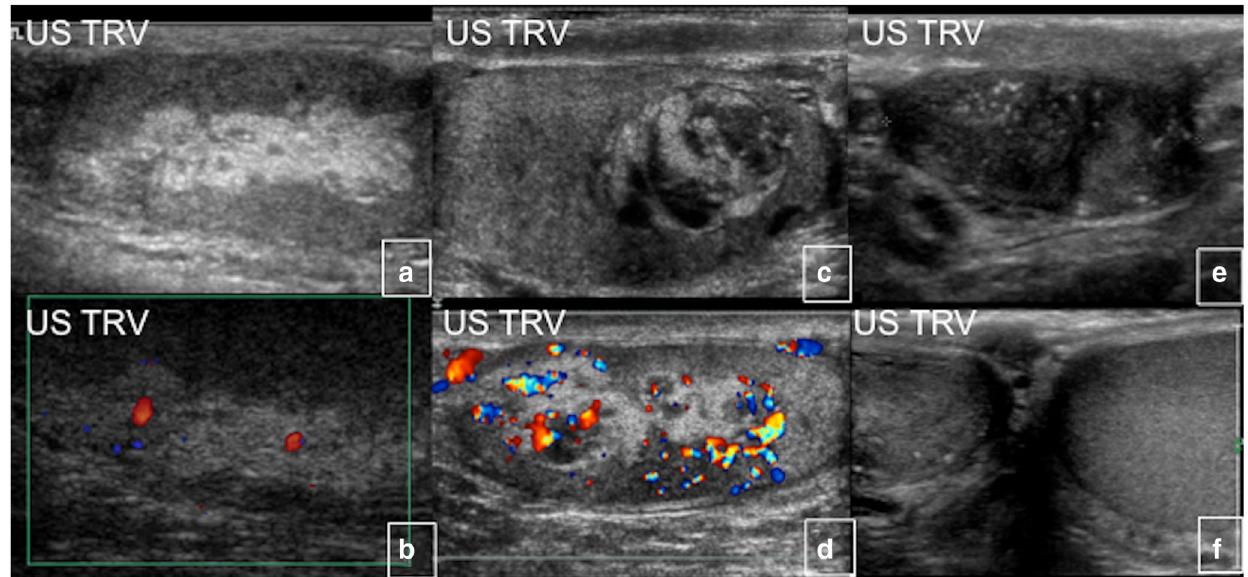
Fig. 25 Testicular abnormalities in McCune-Albright syndrome in three different patients. a , b Ultrasound (US) of the testicles shows extensive echogenic material secondary to Leydig cell hyperplasia. c , d The heterogeneous appearance of the testicle with more focal, well-